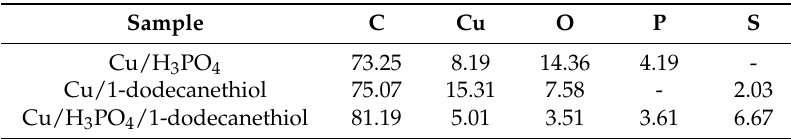
Table 1. The atomic ratios (%) of elements on detected samples.